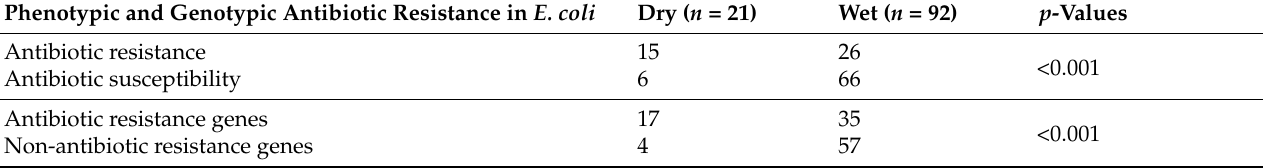
Table 6. Association between antibiotic susceptibility and antibiotic resistance genes of E. coli and season (dry and